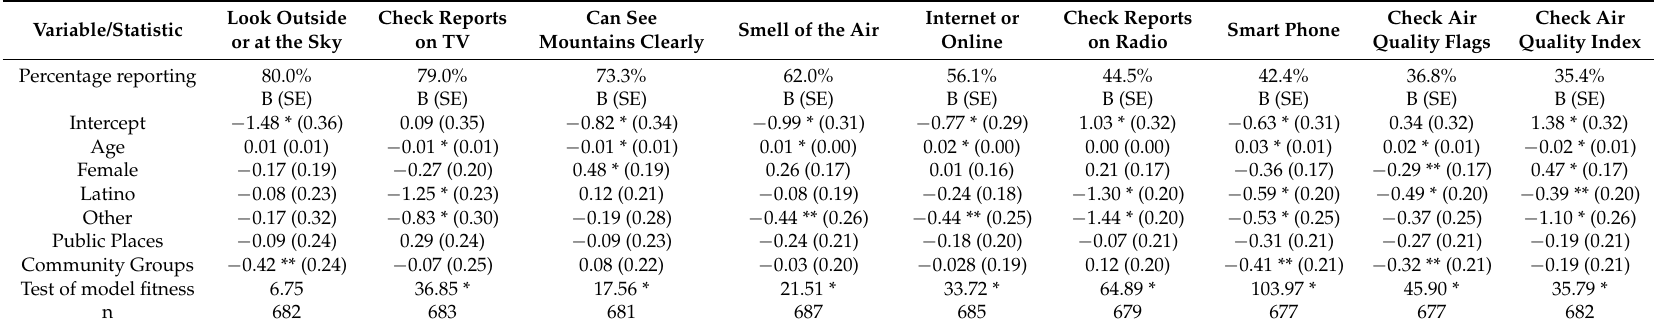
Table 6. Sources of information about air